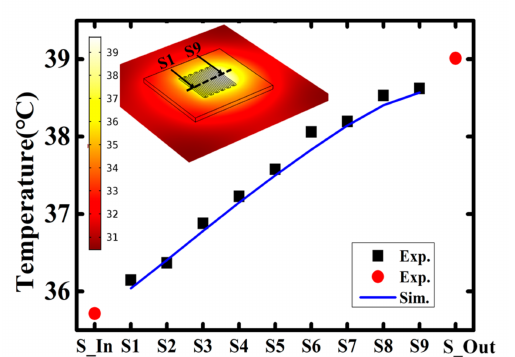
Figure 9. Measured and simulated spatial temperature distribution of the heat sink under the condition of flow is 100 mL/h.